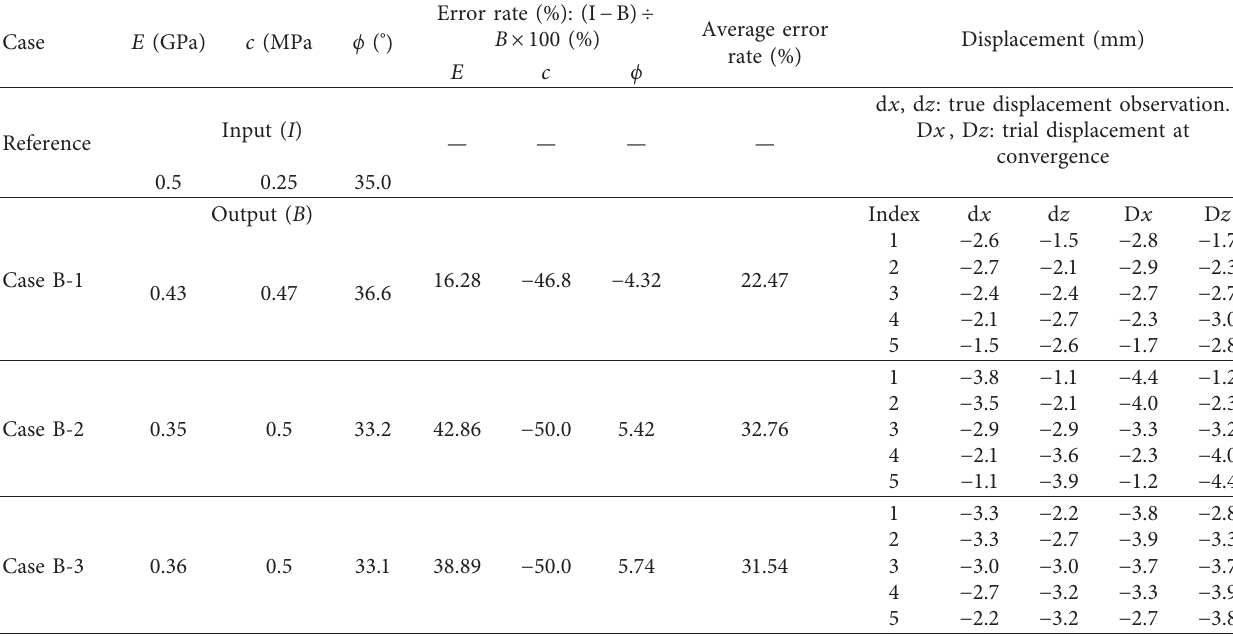
Table 5: Results of back analysis on a segment-lined tunnel using displacement.